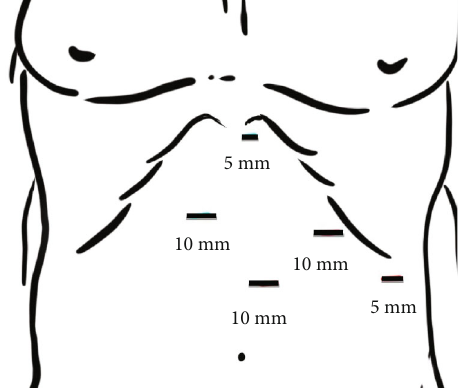
Figure 2: Diagram indicating the position of the trocars. The left and right 10mm ports are for the surgeon ’ s hands. The supraumbilical port is for the camera. The liver retractor uses the 5mm subxiphoid incision. Assistant ’ s left hand uses the 5mm port located on the left fl ank. Supplementary material (video):